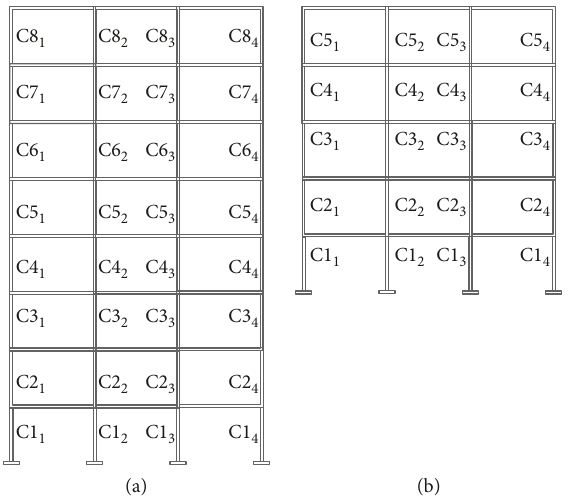
Figure 13: Column section numbering: (a) 8-story frame and (b) 5- story frame.